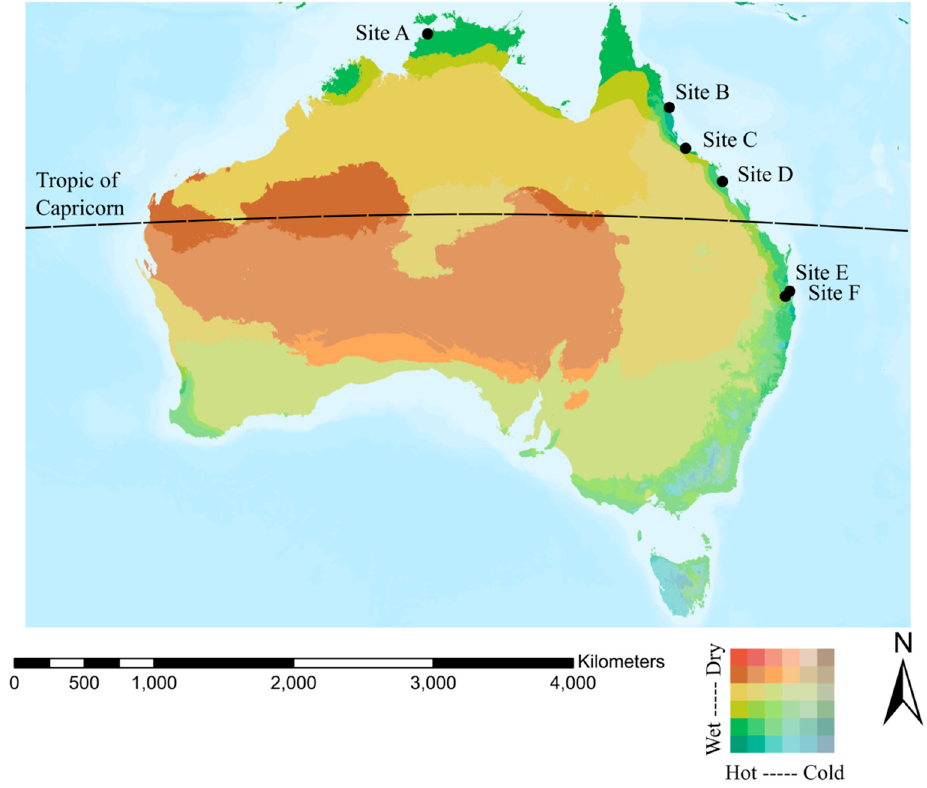
Figure 1. Climate map of Australia showing hospital site locations. Climate layer consists of 37 bioclimate zones derived from a combination of moisture and temperature variables, source: Esri, HERE, Garmin, FAO, NOAA, USGS, © OpenStreetMap contributors and the GIS User Community, Source: Esri; Metzger, et.al. 2012.